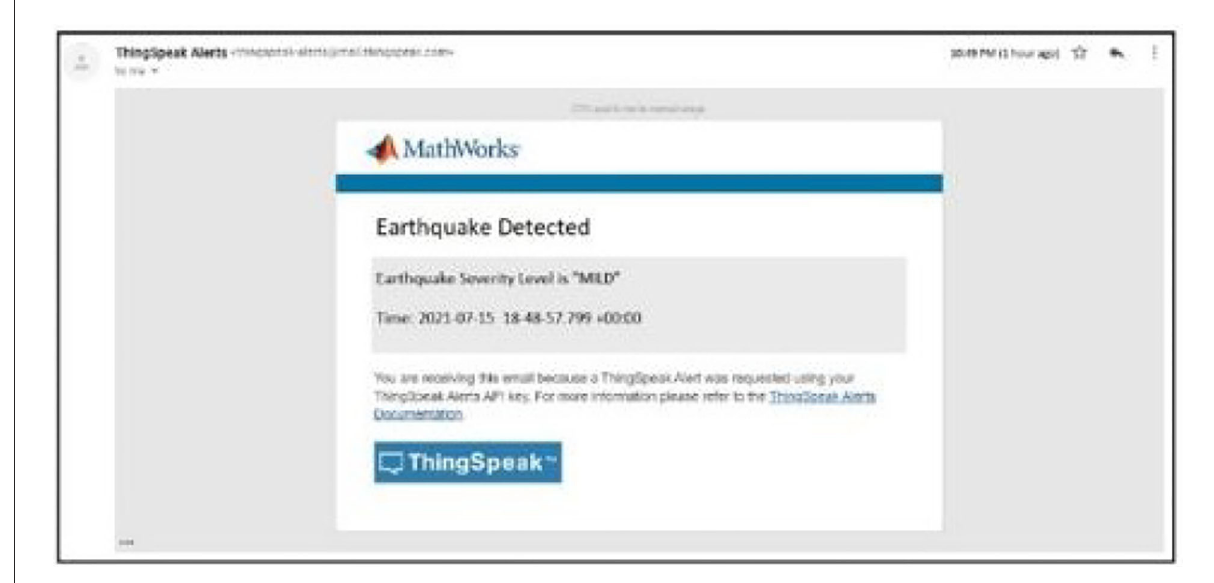
FIGURE11 The Emails Received when pre-defined agent data value conditions were